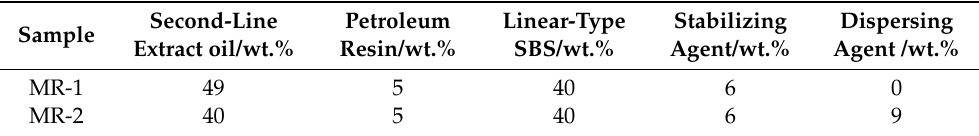
Table 3. Basic composition of the rejuvenators.